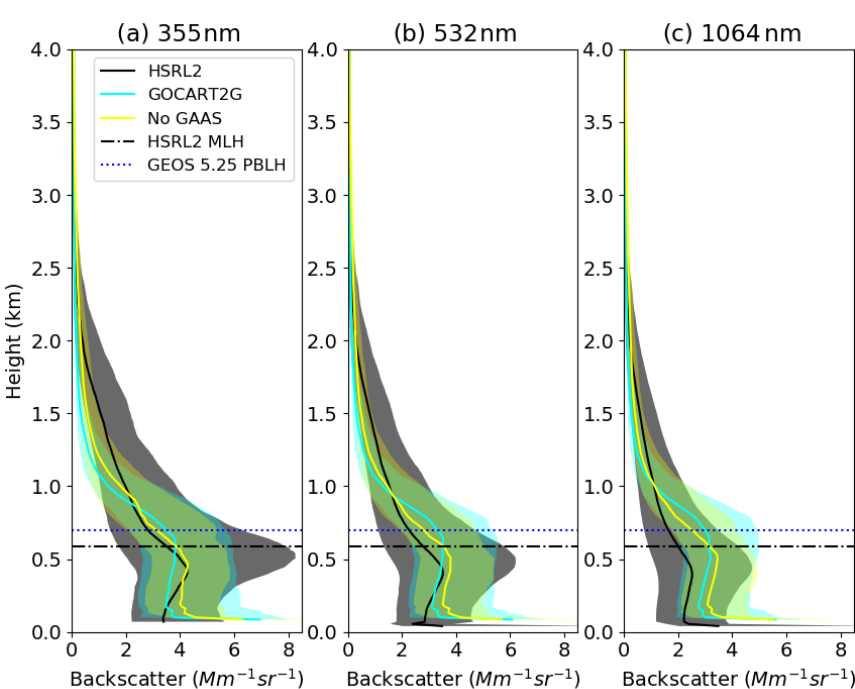
Figure 3. Median backscatter at (a) 355nm, (b) 532nm, and 1064nm during all research flights from the HSRL2, GOCART2G, and GOCART2G without aerosol assimilation (No GAAS). Profiles are shaded between the 25th and 75th percentiles. Mixed layer height (MLH) from the HSRL2 and planetary boundary layer (PBL) height in GEOS are added for reference as dashed lines. Note that PBL height for GOCART2G is the same as GEOS 5.25. An analogous figure with all model simulations can be found in the